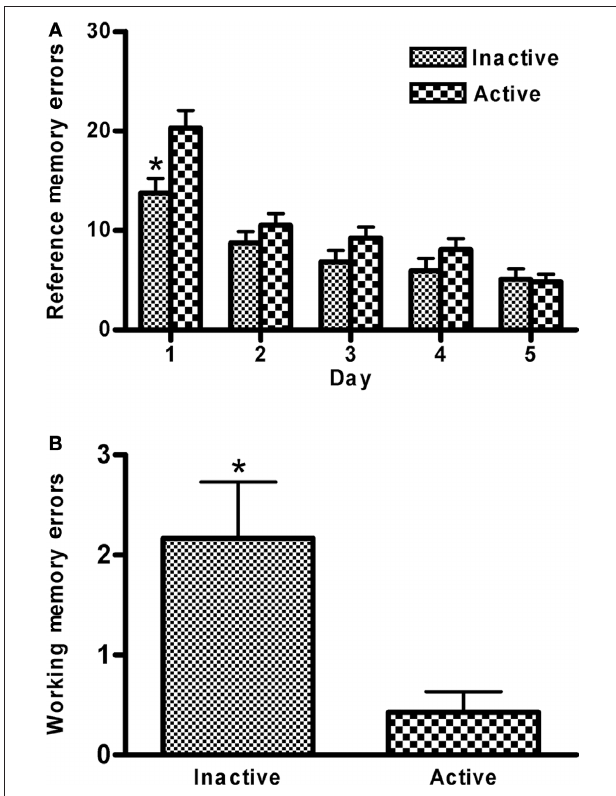
Figure 6 | Spatial discrimination. (A) Animals trained during their active phase made more reference memory errors on this task, especially on the first day of training, than animals trained during their inactive phase (phase × training interaction p < 0.03; * p < 0.02). (B) On a memory retention 2 weeks following training, animals traine tested during their active phase committed fewer working memory errors compared to animals trained and tested during their inactive phase (* p < 0.02). Values are group mean ±